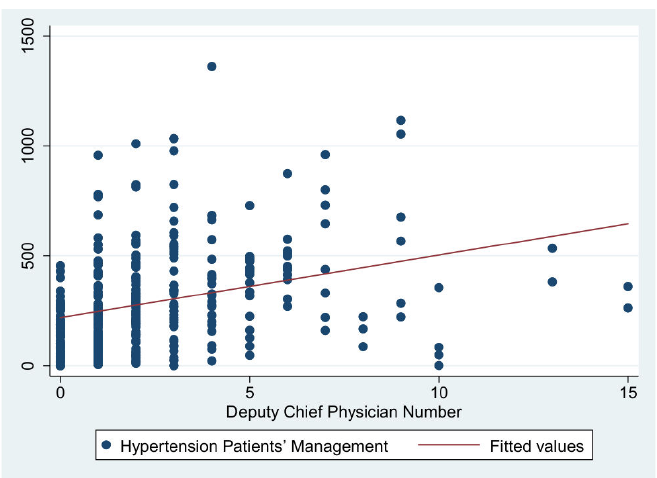
Figure 4. Scatter diagram of hypertension patient management and total number of deputy chief physicians.